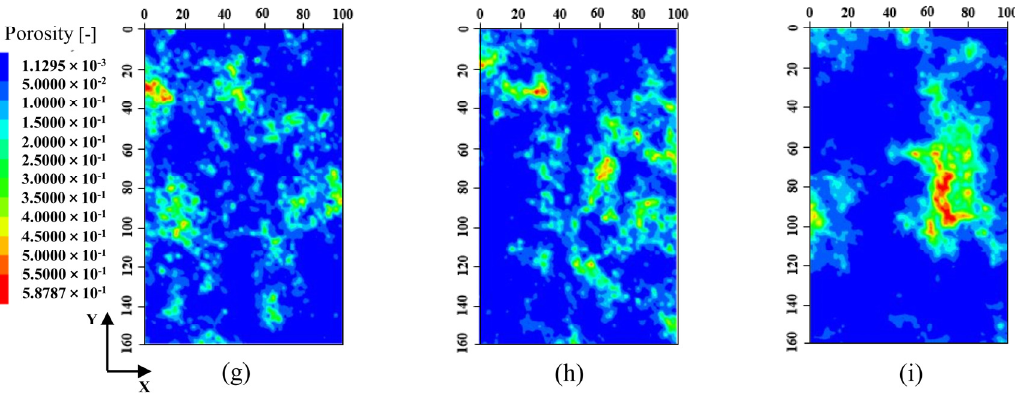
Figure 4. Generated porosity distribution field. ( a ) SD = 0.025 (-), CL = 12.5 m; ( b ) SD = 0.025 (-), CL = 25 m; ( c ) SD = 0.025 (-), CL = 50 m; ( d ) SD = 0.05 (-), CL = 12.5 m; ( e ) SD = 0.05 (-), CL = 25 m; ( f ) SD = 0.05 (-), CL = 50 m; ( g ) SD = 0.1 (-), CL = 12.5 m; ( h ) SD = 0.1 (-), CL = 25 m; ( i ) SD = 0.1 (-), CL = 50 m.